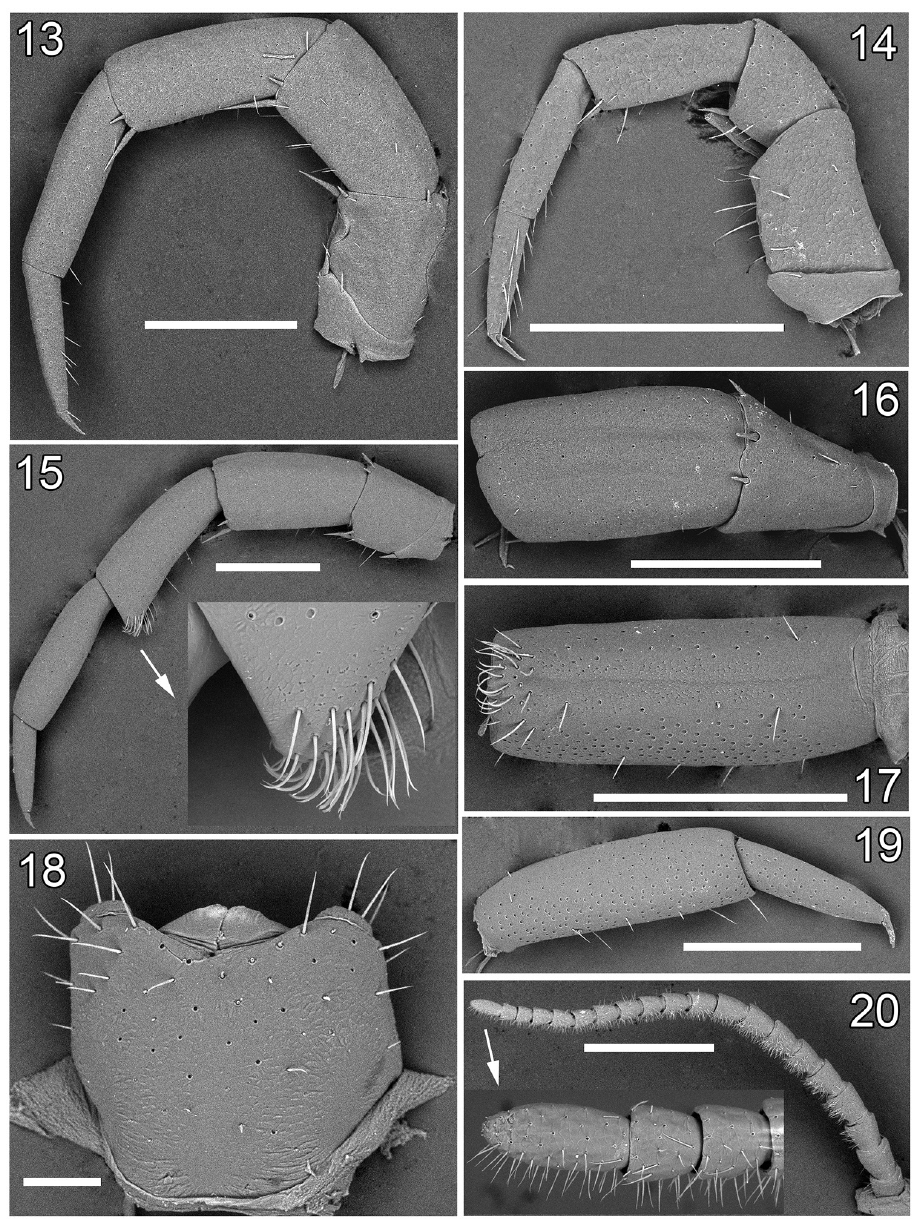
Figures 13–20. Lithobius ( Chinobius ) yuchernovi sp. n., male paratype. 13 leg 14, lateral view 14 leg 1, lateral view 15 leg 15, lateral view 16 prefemur and femur of leg 15, dorsal view 17 tibia 15, ventral view 18 genital sternite with gonopods, ventral view 19 tarsus 15, lateral view 20 antenna. Scale bars: 0.1 mm ( 18 ), 0.5 mm ( 13, 14, 16, 17, 19 ), 1 mm ( 15, 20